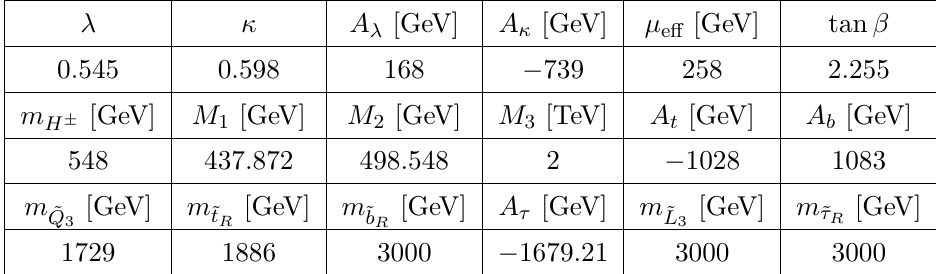
Table 35 . BP17 NMSSM input parameters required by NMSSMCALC for the computation of the NMSSM